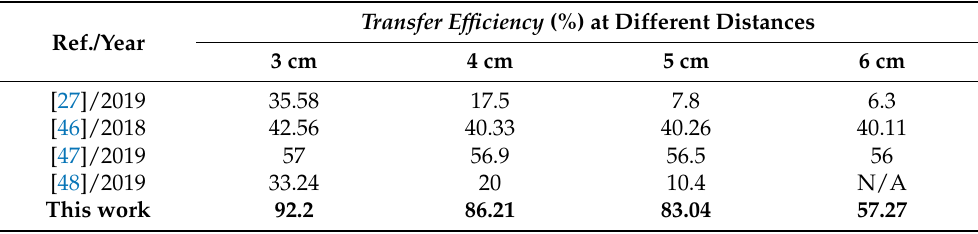
Table 4. Comparison of the current work with previous studies in terms of transfer efficiencies. Ref./Year